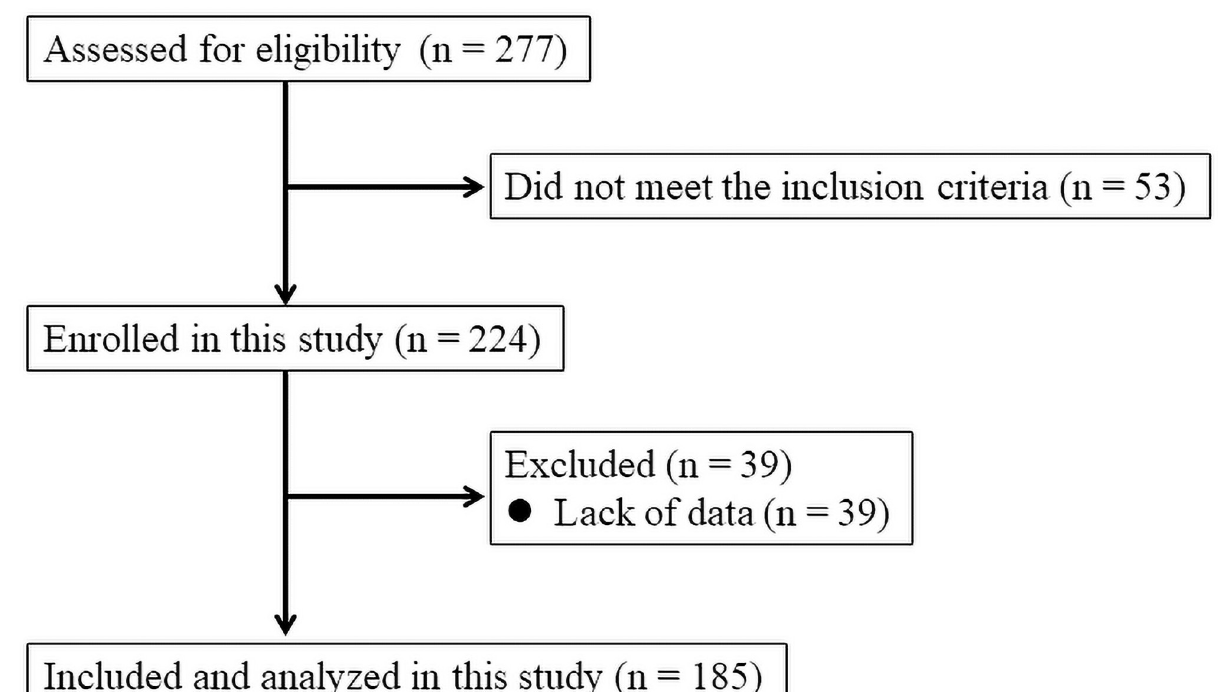
Fig 1. Patients flow